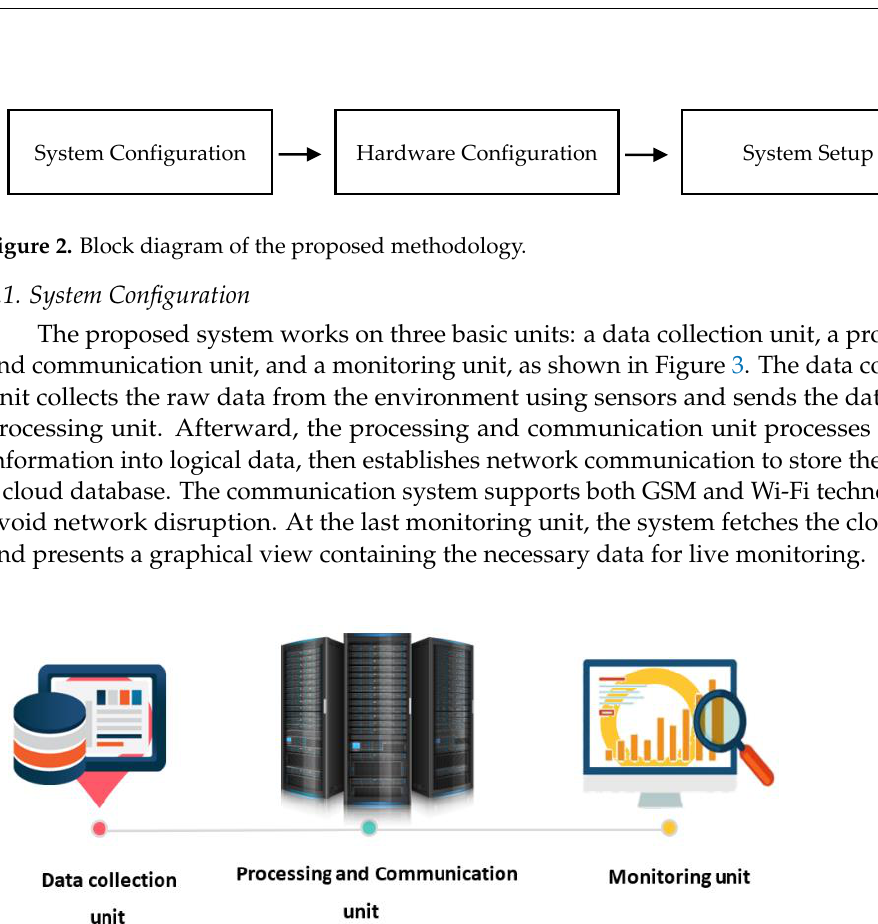
Figure 3. Architectural overview of the proposed system.